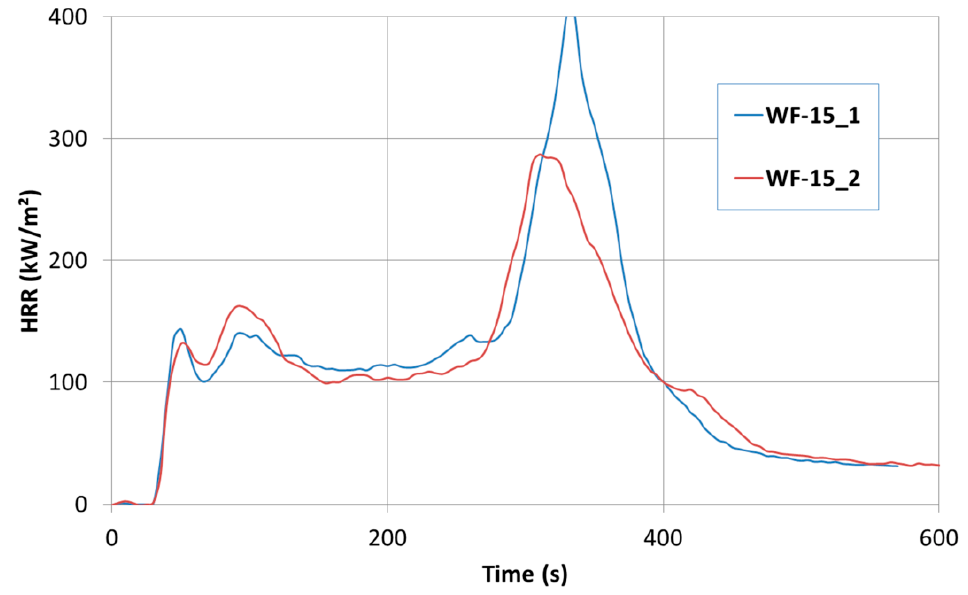
Figure 9. Heat Release Rate (HRR) curves vs. time in the cone calorimeter ISO 5660-1 for coating WF-15 (two tests).